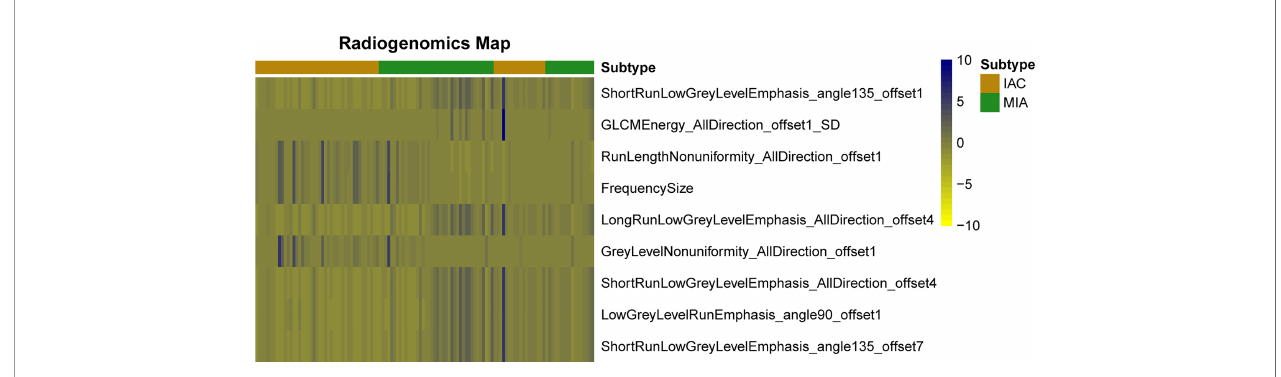
FIGURE 4 | Heat map of radiomics features. Each row represents a feature, and each column represents a lung ground-glass nodule. The fi gure shows the difference between invasive adenocarcinoma and minimal invasive adenocarcinoma in each feature and indicates the classi fi cation ability of